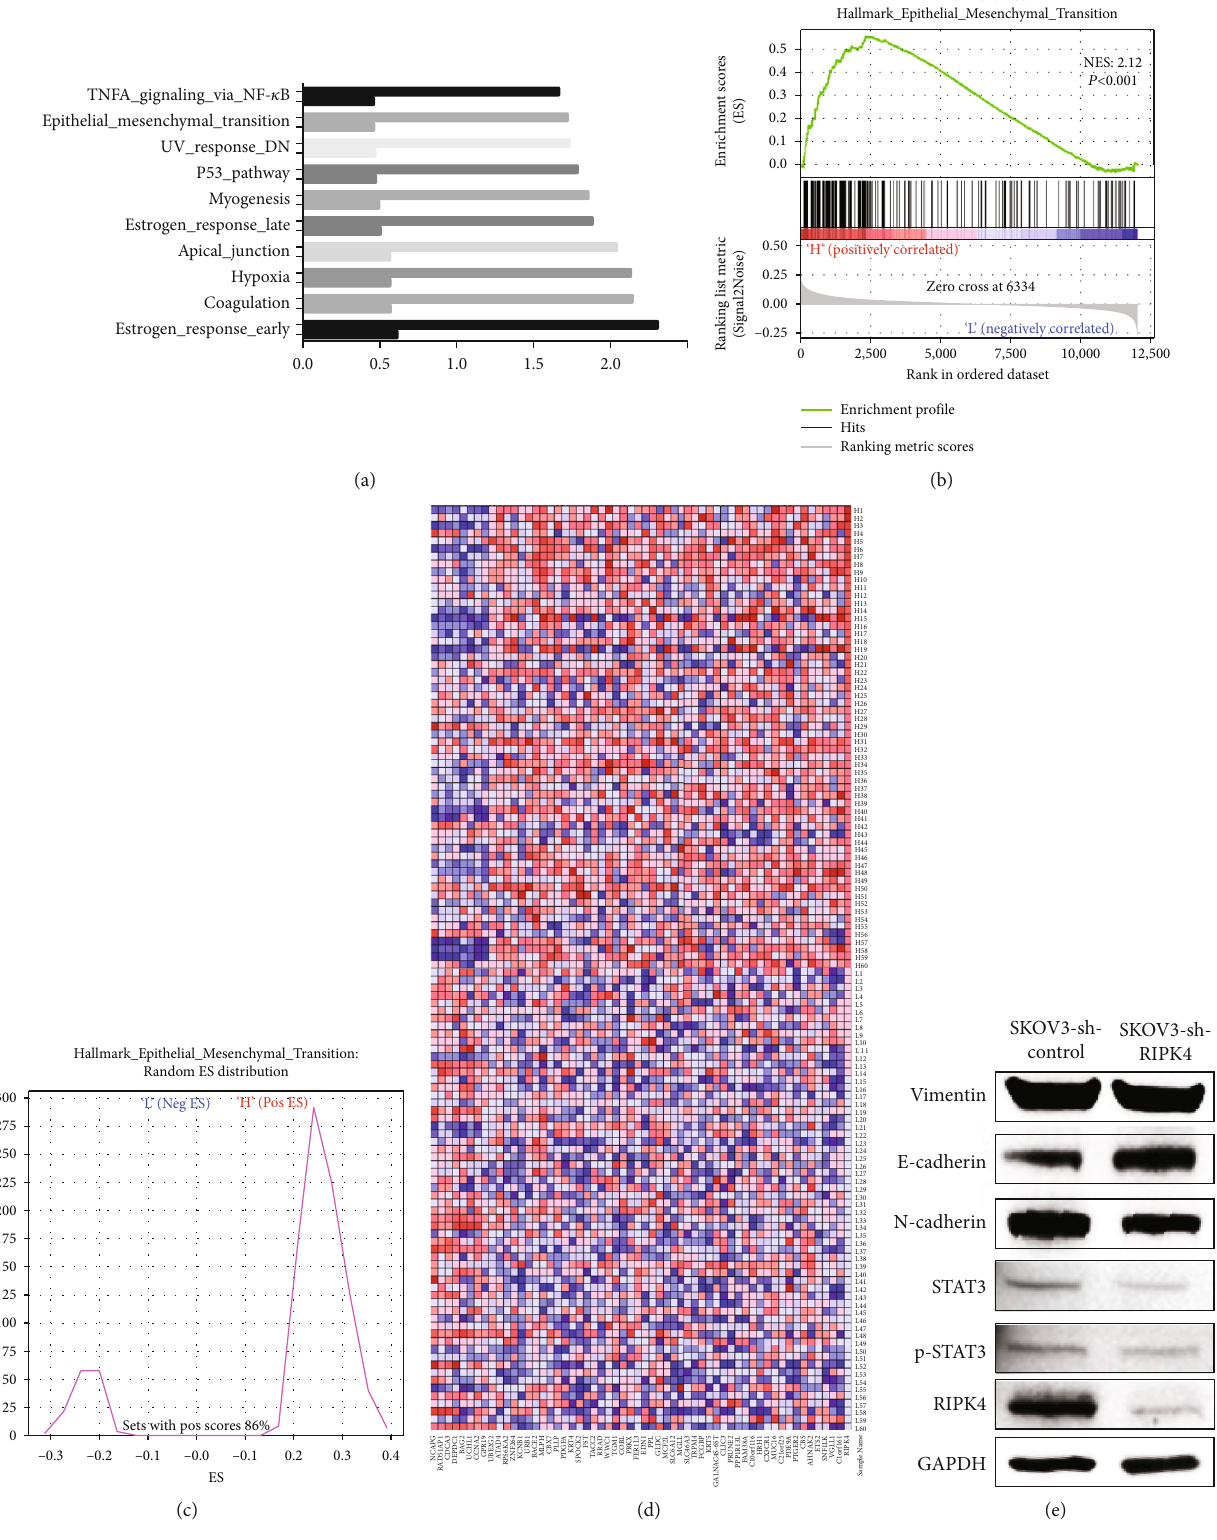
Figure 4: GSEA results. (a) GSEA identi fi ed the top ten pathways in the high RIPK4 expression group based on the TCGA dataset including data from 593 OC patients. (b and c) GSEA showed that the high RIPK4 expression group was associated with EMT. (d) Gene pro fi ling of hallmarks is shown in the heatmaps generated by comparing the high RIPK4 expression group and the low RIPK4 expression group. (e) Western blot assay results demonstrated that the levels of proteins promoting the EMT pathway were decreased in SKOV3-sh-RIPK4 cell